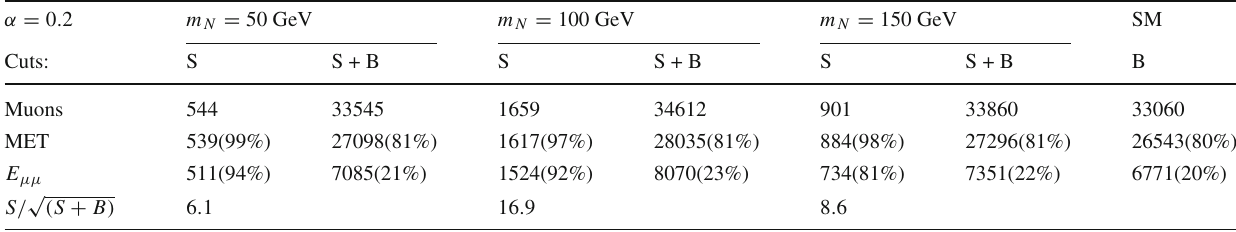
( a ) (b) √ Fig. 4 Number of events ( a ) and A FB μμ ( b ) distributions with E μμ , for α = 0 . 2, (cid:5) = 1 TeV, s = 500 GeV, L = 500 fb − 1 Table 2 e + e − → νμ − μ + ν (pure-leptonic). Number of events for events with MET > 25 GeV. E μμ cut: select events with E μμ < √ ( S + B ) for event- signal-only (S), signal and SM background (S + B, generated with inter- 240 GeV (see Fig. 4a). Signal significance: S / √ s = 500 GeV, L = 500 fb − 1 . ference), and SM background (B) for counting Muons cut: one muon and anti-muon in final state. MET cut: select